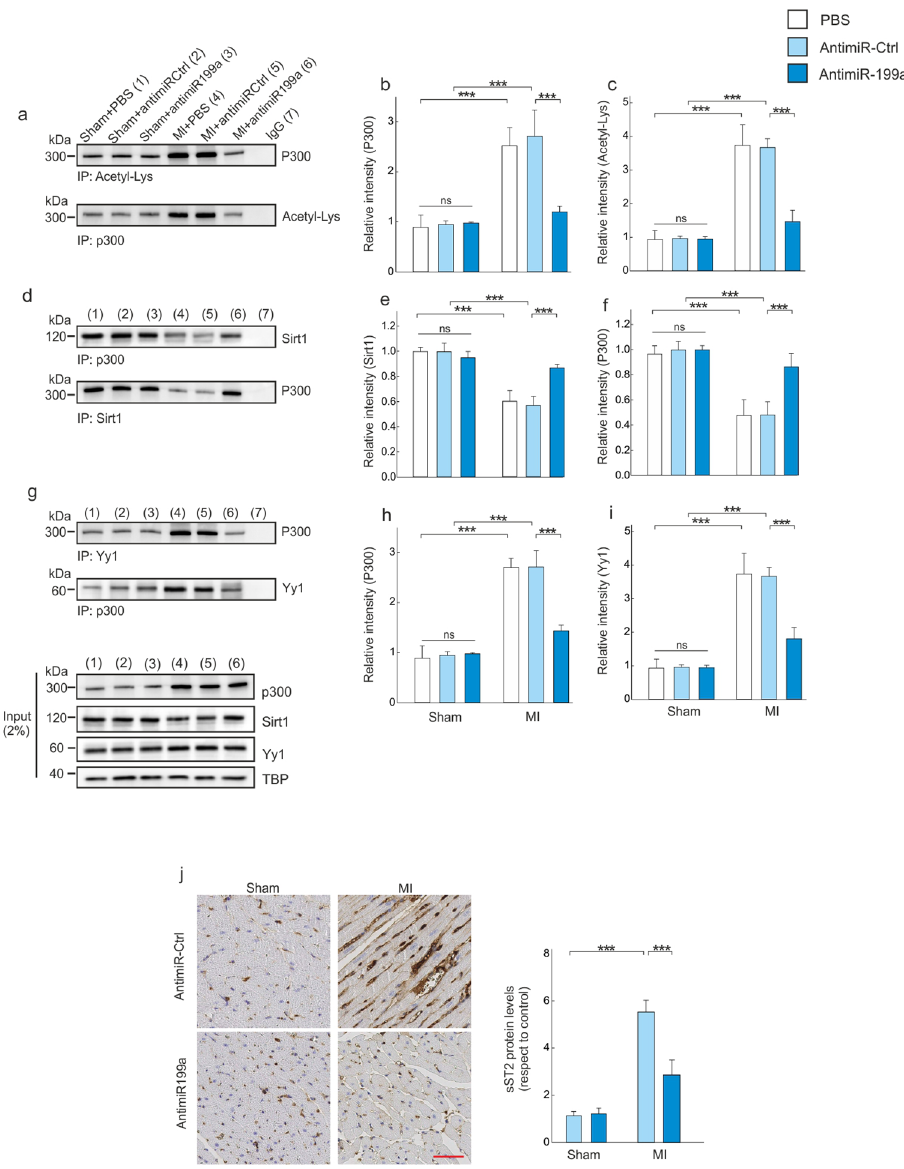
Figure 4. AntimiR-199a therapy prevents Sirt1 downregulation and P300 acetylation. ( a ) Co-immunoprecipitation of the P300-acetyl-Lys complex. ( b ) Densitometric analysis of the co-immunoprecipitated P300 protein. ( c ) Densitometric analysis of the co-immunoprecipitated acetyl-Lys. ( d ) Co-immunoprecipitation of the Sirt1/P300 complex. ( e ) Densitometric analysis of the co-immunoprecipitated Sirt1 protein. ( f ) Densitometric analysis of the co-immunoprecipitated P300 protein. ( g ) Co-immunoprecipitation assay of the P300/Yy1 complex. ( h ) Densitometric analysis of the co-immunoprecipitated P300 protein. ( i ) Densitometric analysis of the co-immunoprecipitated Yy1protein. ( j ) Representative immunohistochemical images and quantifications of sST2 in the remote LV region of sham and MI mice treated with antimiR-Ctrl or animiR-199a; Scale bar: 25 μm. Representative full western blot images are shown in supplementary material. All quantifications derive from n = 10 mice/group. All quantitative data are reported as means ± SEM. ***P < 0.001 determined by two-way ANOVA followed by Bonferroni’s post hoc test. Abbreviations as in Figs. 2 and